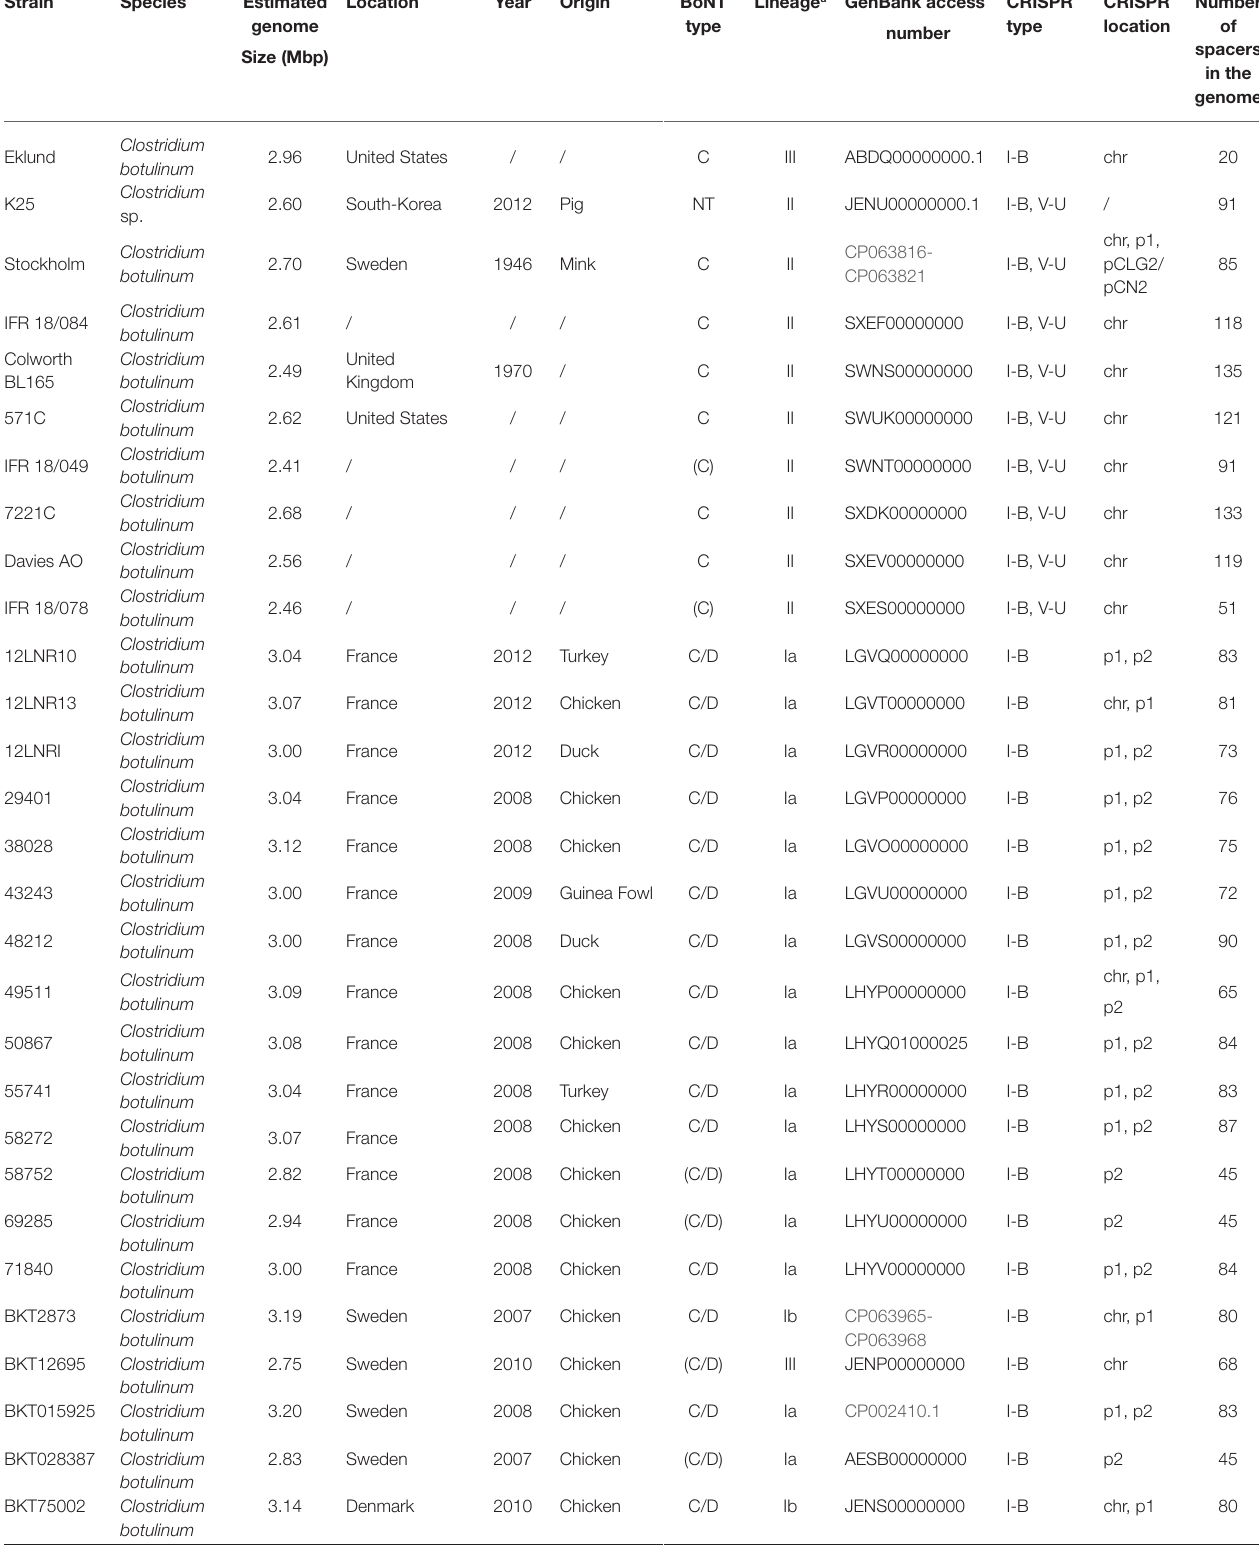
TABLE 1 | Strain metadata and clustered regularly interspaced short palindromic repeats (CRISPR)-CRISPR-associated proteins types. Strain Species Estimated